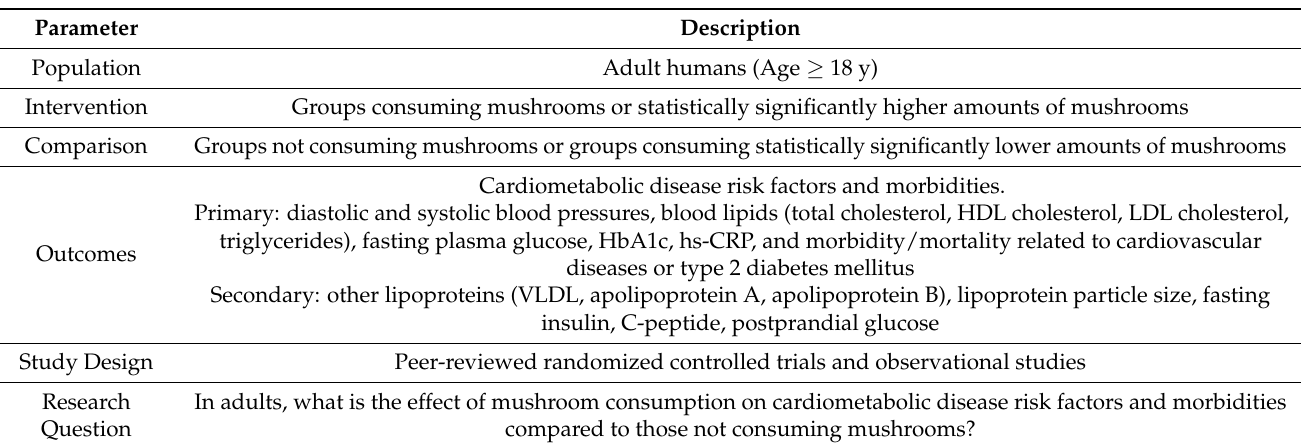
Table 1. Description of the research question and PICOS for a systematically searched literature review. Parameter